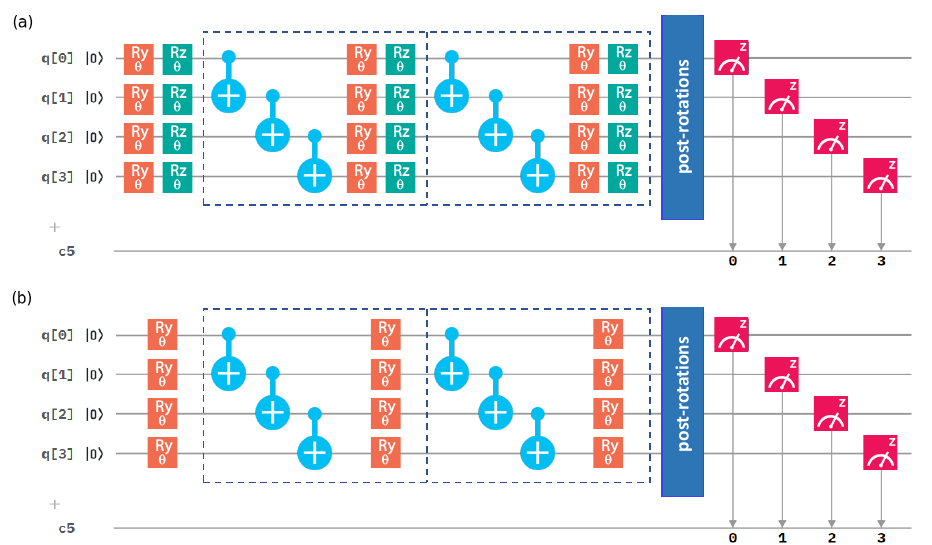
Figure 1. A scheme of the 4-qubit quantum circuits for calculations of the ground-state energy. The circuit depth was set to 2. Dashed lines represent blocks of two layers—the entangled layer and the rotation layer. ( a ) The R y R z variational circuit. ( b ) The R y variational